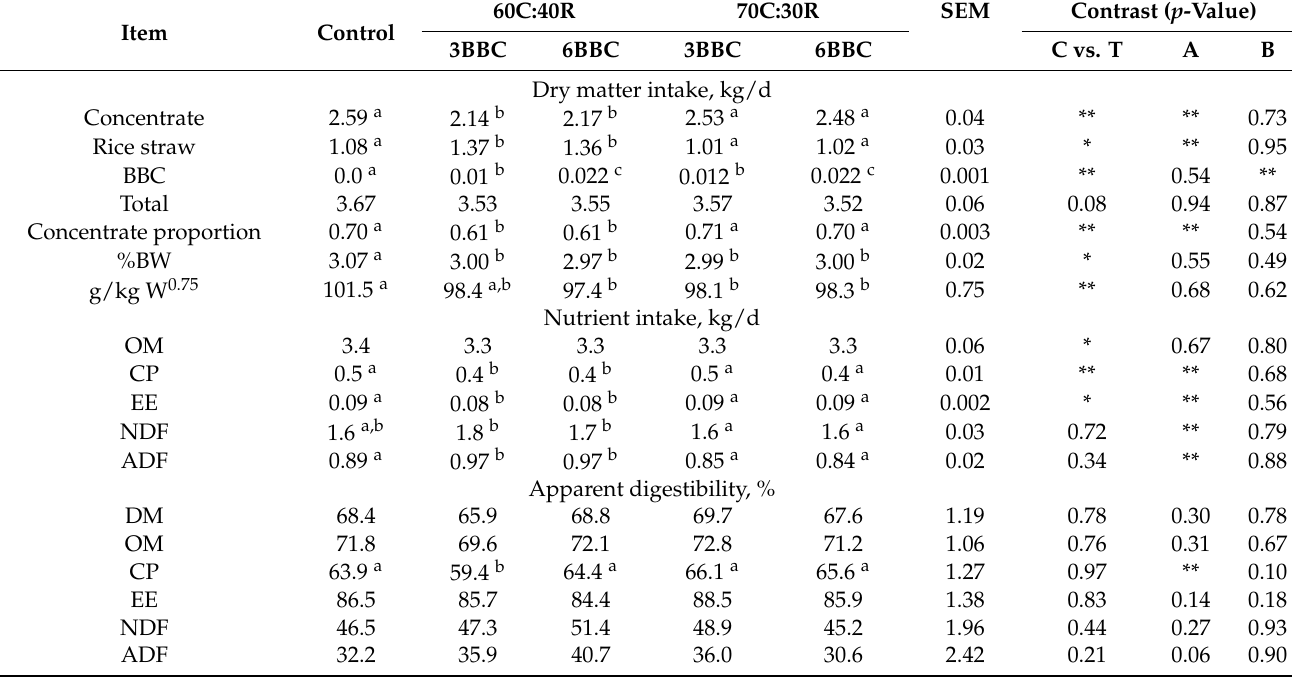
Table 2. Feed intake and apparent digestibility in beef cattle fed with different concentrate-to-roughage ratio diets and different levels of BBC